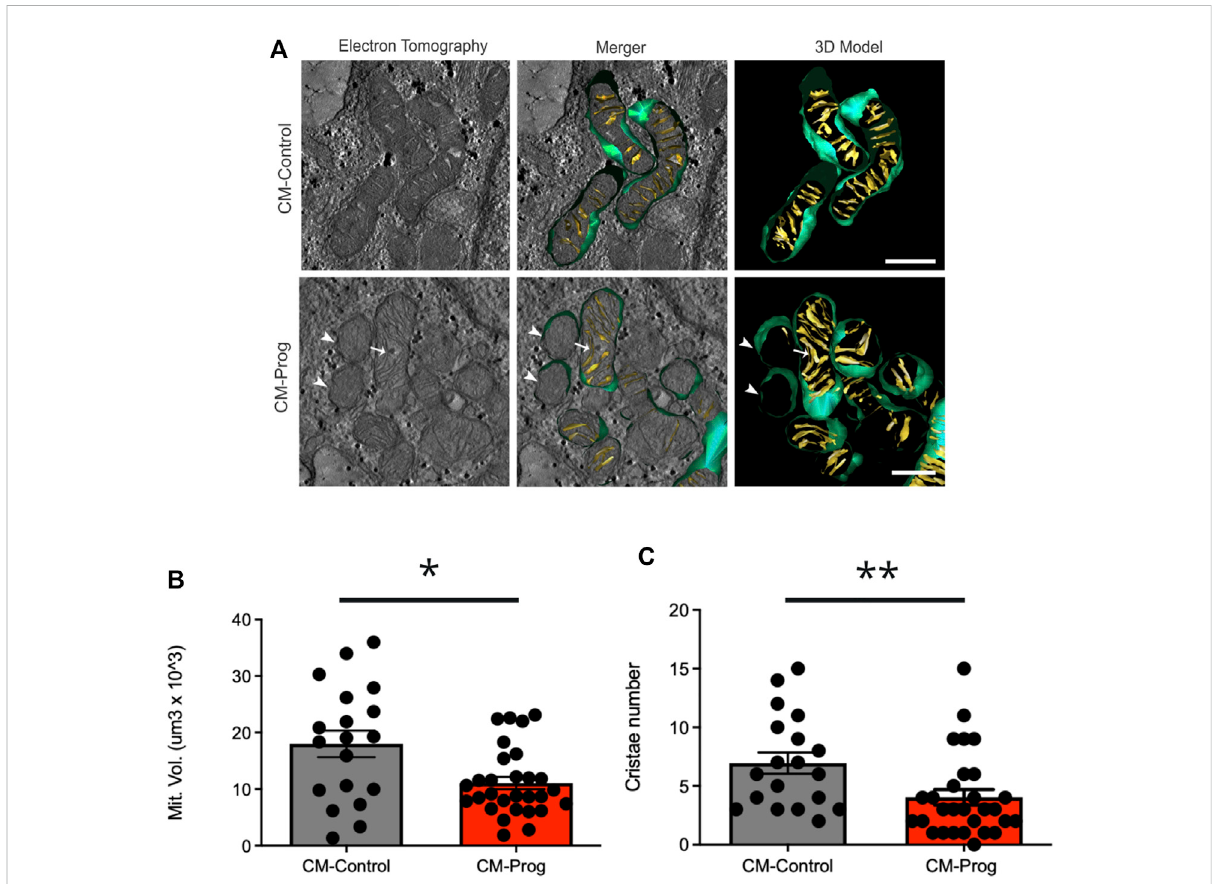
FIGURE 4 Electron tomography and mitochondrial 3D model in cardiomyocytes (A) Virtual z-slices obtained from tomograms, merged image and representative3DmodelofcontrolandHGPScardiomyocytes.Mitochondriapresentinganabsenceofcristae(arrowhead)orcristaerunningparallel to the main axis of the organelle (arrow) were observed in the CM-Prog condition. Scale bar: 300 nm. (B) Mitochondrial volume quanti fi cation. (C) Totalnumberofmitochondrialcristae.Scatterplotshowsvaluesfromindividualmitochondria;horizontalbarsrepresentmeanvalueswithSEM. * indicates p < 0.05 and ** p < 0.01 between groups with student ’ s t-test (CM-Control n = 19; CM-Prog n =